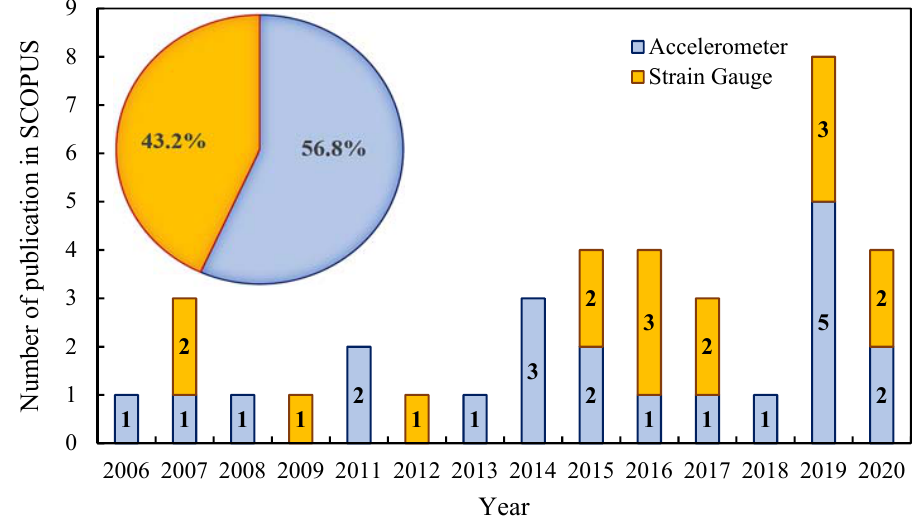
Figure 8. Distribution of the reviewed articles associated with the application of LCSs for structural monitoring from 2006 to 2020.